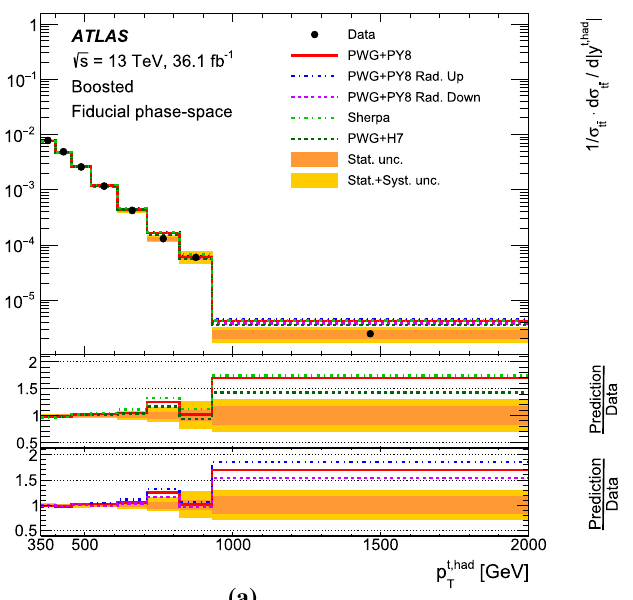
resent the statistical and total uncertainty in the data. Data points are placed at the centre of each bin. The lower panel shows the ratios of the simulations to data